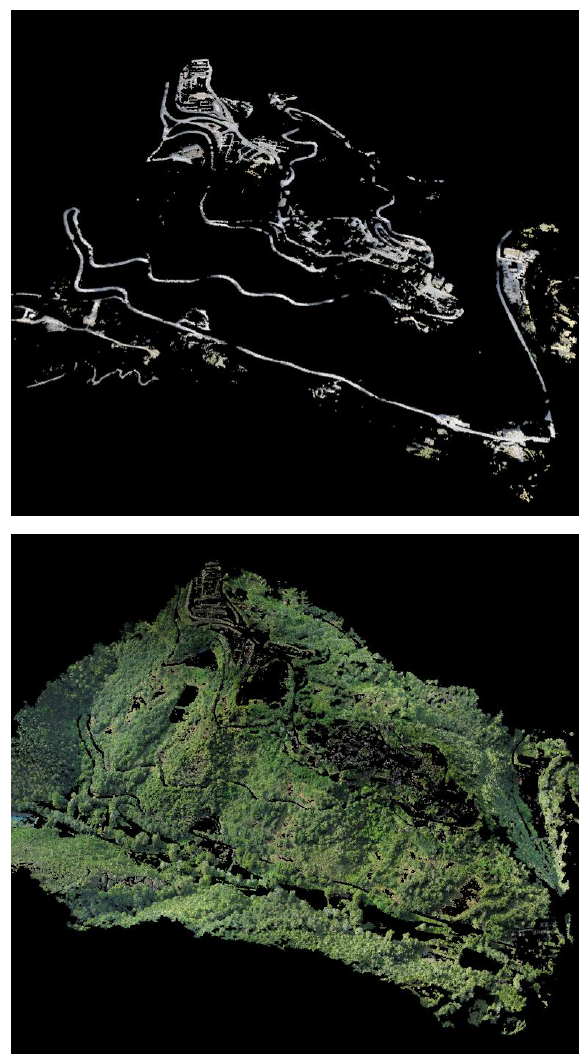
Figure 13. Point cloud classification: road surface (top) and high vegetation (bottom)